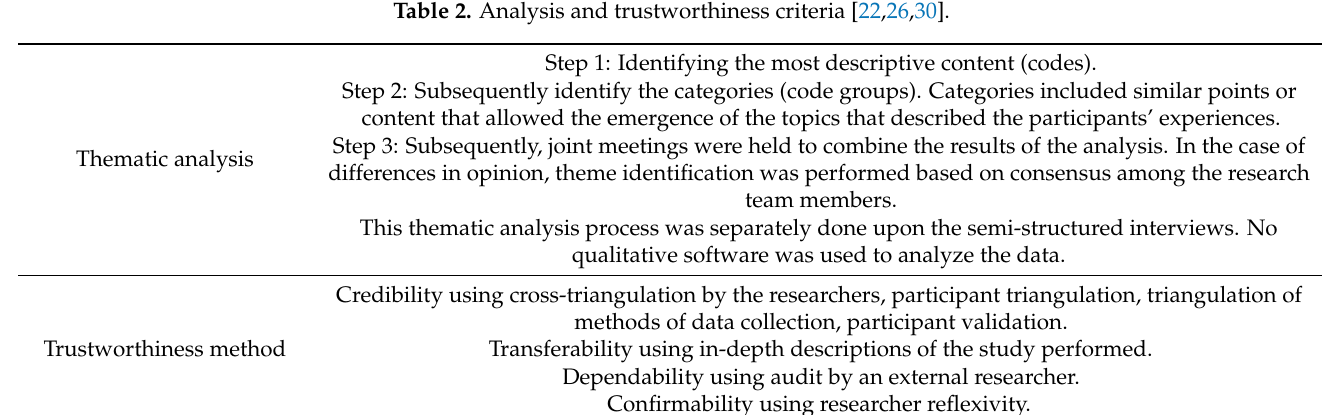
Table 2. Analysis and trustworthiness criteria [22,26,30].